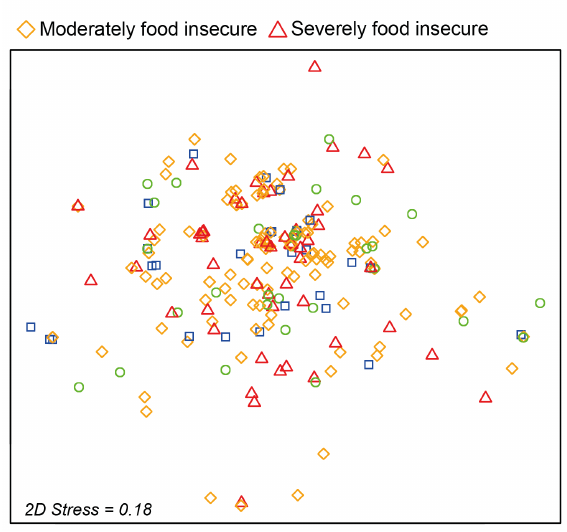
Fig. 4 . Ordination plot of livelihood activity composition among the four Household Food Insecurity Access Scale (HFIAS) categories. Data have been ordinated from the Bray– Curtis dissimilarity